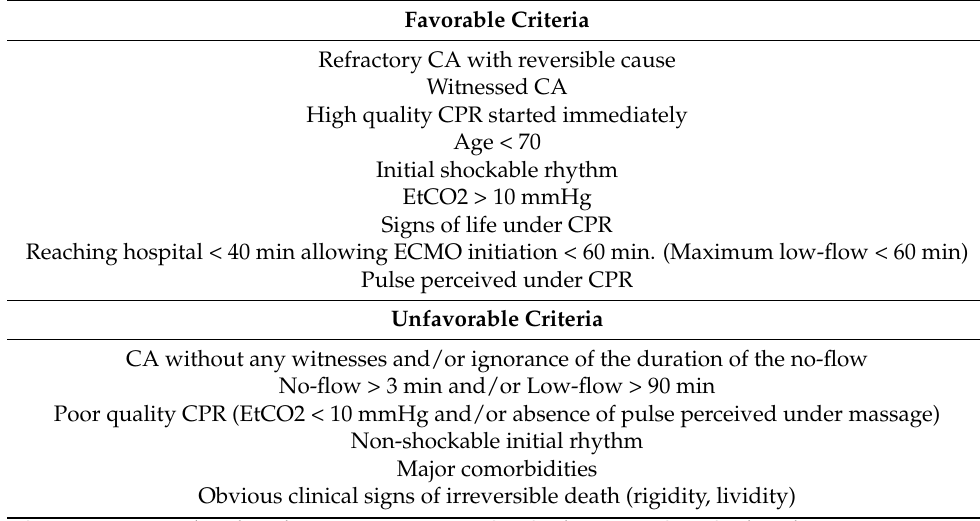
Table 2. Favorable and unfavorable criteria for initiating an in-hospital ECPR for an out-of-hospital cardiac